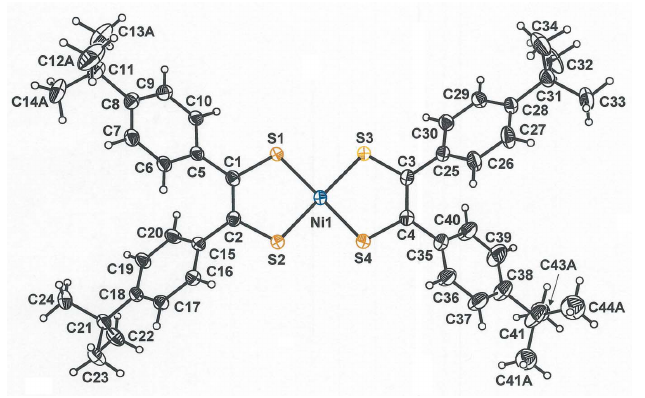
Figure 1 Atom labeling for 1 . Displacement ellipsoids are shown at the 50% probability level. For clarity, the disordered t Bu groups (C11 ! C14 A and C41 ! C44 A ) are edited to show only one of the two orientations.